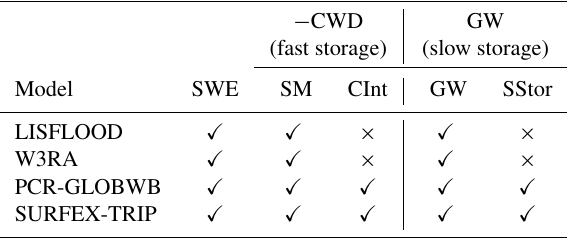
Table 2. The terrestrial water storage (TWS) components as repre- sented by the selected process models. While the hybrid hydrolog- ical model (H2M) represents snow water equivalent (SWE) explic- itly, like the process models, the remaining TWS components are partitioned into soil cumulative water deficit (CWD) and ground- water (GW), which can be interpreted as fast and slow storage. To compare these components to the global hydrological models (GHMs), we calculated the storage as soil moisture plus canopy in- terception (CInt) if available and groundwater plus surface storage (SStor) if available, respectively. Note that CWD represents a deficit and, thus, it corresponds to negative soil water storage. −